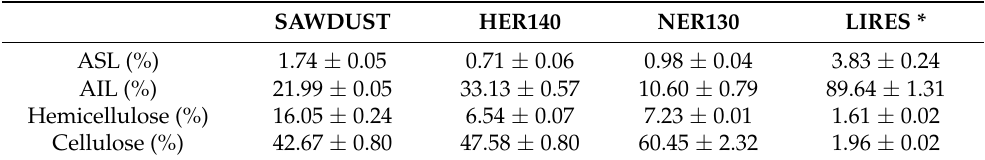
Table 2. Lignocellulosic composition of the residual eucalyptus sawdust and the derived fractions after acid-alkaline